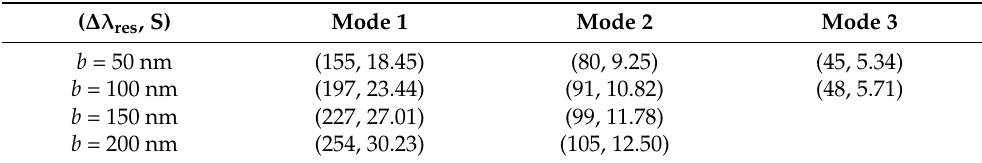
Table 2. Comparison of ( ∆ λ res (nm), S(nm/MPa)) of the designed structure for b = 50, 100, 150, and